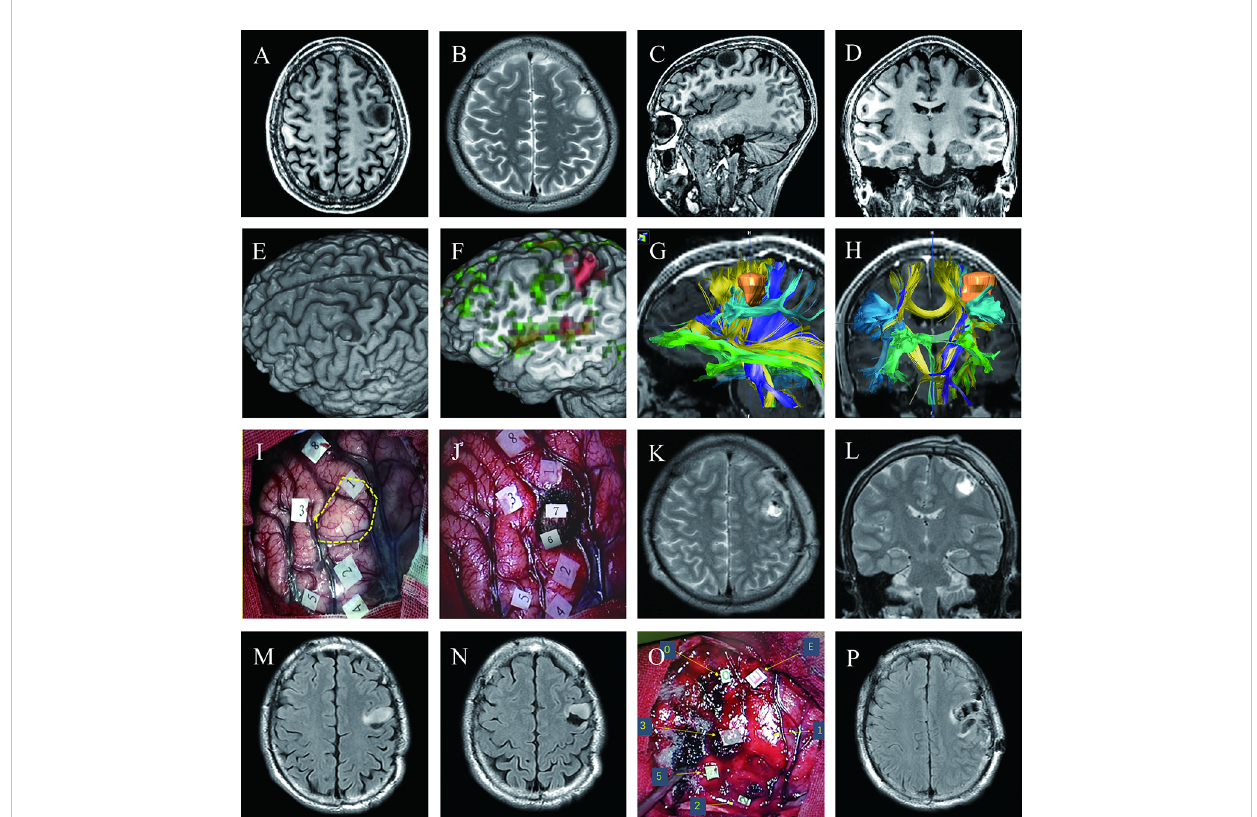
FIGURE 2 Maximum safe resection of astrocytoma with IDH mutation (WHO Grade 2) in the inferior left precentral gyrus in two successive awake craniotomies over four years (Cases 3 and 14); (A – D) Pre-operative T1 axial, T2 axial, T1 sagittal, and T1 coronal MRI; (E) Surface rendering of pre-operative T1- weighted MRI revealed a tumor in the middle of the left precentral gyrus, which was separated into the dorsal and ventral parts by the tumor; (F) Surface rendering of functional areas overlapped with T1-weighted MRI and fMRI; Red denotes active sites for hand grasp task; green represents active sites for naming task; (G, H) Pre-operative planning using neuro-navigation showed a close relationship between the tumor and white matter fi bers; (I) Intraoperative view before tumor resection; An ultrasonic tumor border is marked with the dotted yellow circle. Numbers on tags denote zones of positive DES mapping (2 and 4, fi nger movement; 3, mouth sensation; 5, fi nger sensation; 1, speech arrest during counting; 8, anomia during naming) (J) Intraoperative view after tumor resection; glioma was removed until eloquent neural structures were encountered at cortical and subcortical levels using subcortical DES; Tag 6, pyramidal tract for right thumb movement; 7, area responsible for speech arrest during counting; Postoperative axial (K) and coronal (L) T2 FLAIR-weighted MRI demonstrated total tumor resection; (M, N) Follow-up MRI revealed a recurrent tumor anterior to the previous surgical residual cavity; (O) Intraoperative view of the second surgery before tumor resection; Number and letter tags denote zones of positive DES mapping (2, thumb movement; 3, mouth sensation; 5, fi nger sensation; 0, 1, and E, both speech arrest and interrupt of hand grasp during a dual coordinate task); (P) Postoperative axial T2 FLAIR MRI showed subtotal tumor resection with a residue of 0.5 cm 3